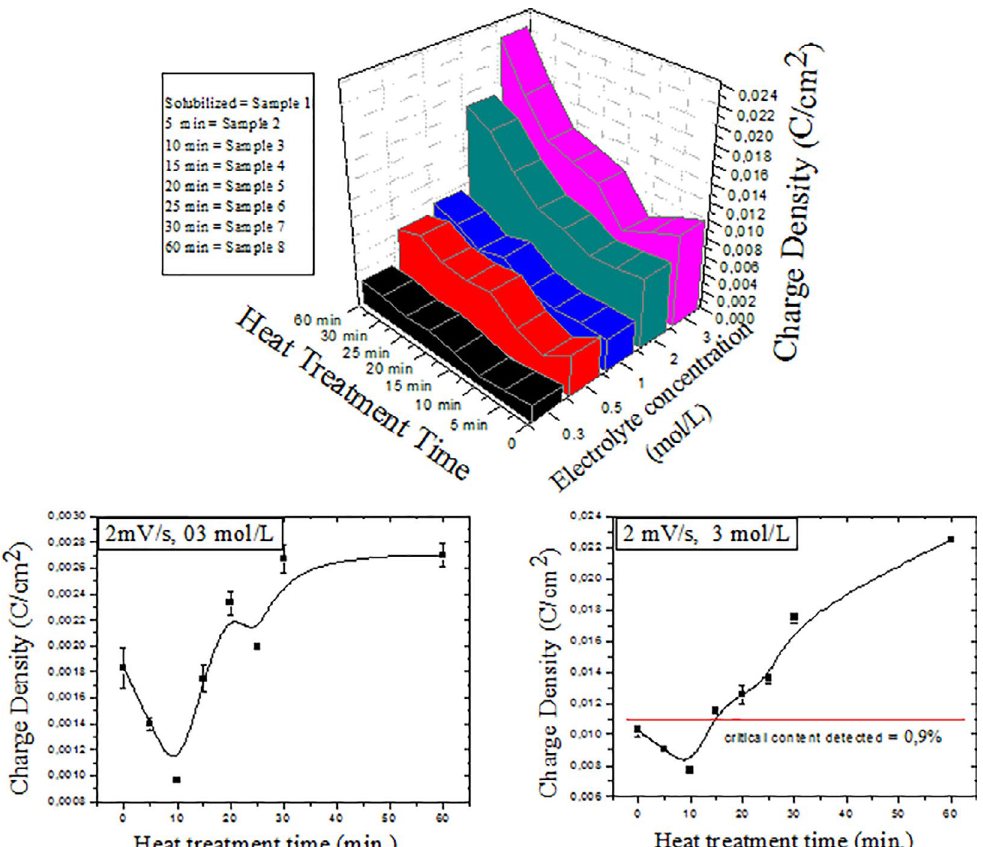
Figure 9. Effect of Concentration Electrolyte (KOH) on the charge density profile of the analyzed samples. a) Effect on the charge density profile for various concentrations of the electrolyte, b) and c) effect for two concentrations isolated 0.3 and 3 mol/L, respectively. Scan rate employed